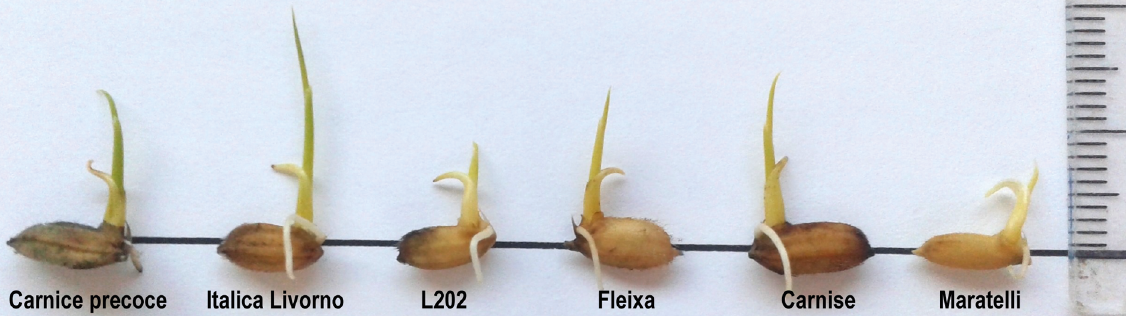
Fig 3. Variation in coleoptile length after 21 d at 15˚C of germinating seeds of rice cultivars (from left to right) Carnice precoce, Italica Livorno, L-202, Fleixa, Carnise and Maratelli.